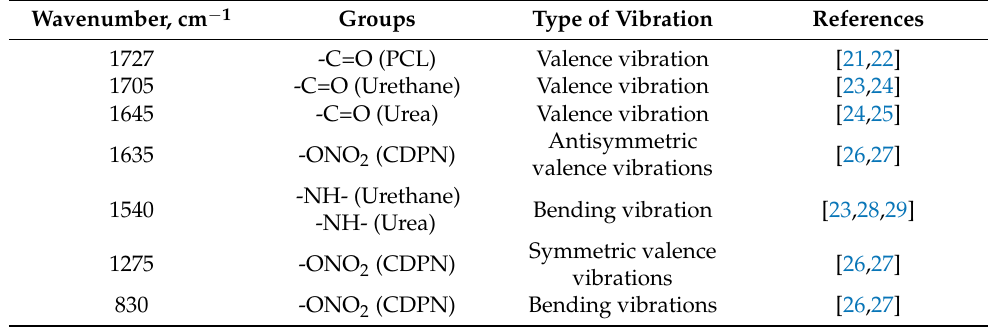
Table 3. Vibrational band frequencies for WPU